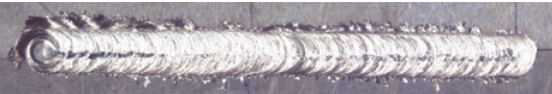
Figure 6: Weld coupon obtained with Zn as intermediate metal; at the mid region of welded plate there is no longitudinal crack indicat- ing good weld there. Most of the microstructure samples of this coupon were broken during cutting.